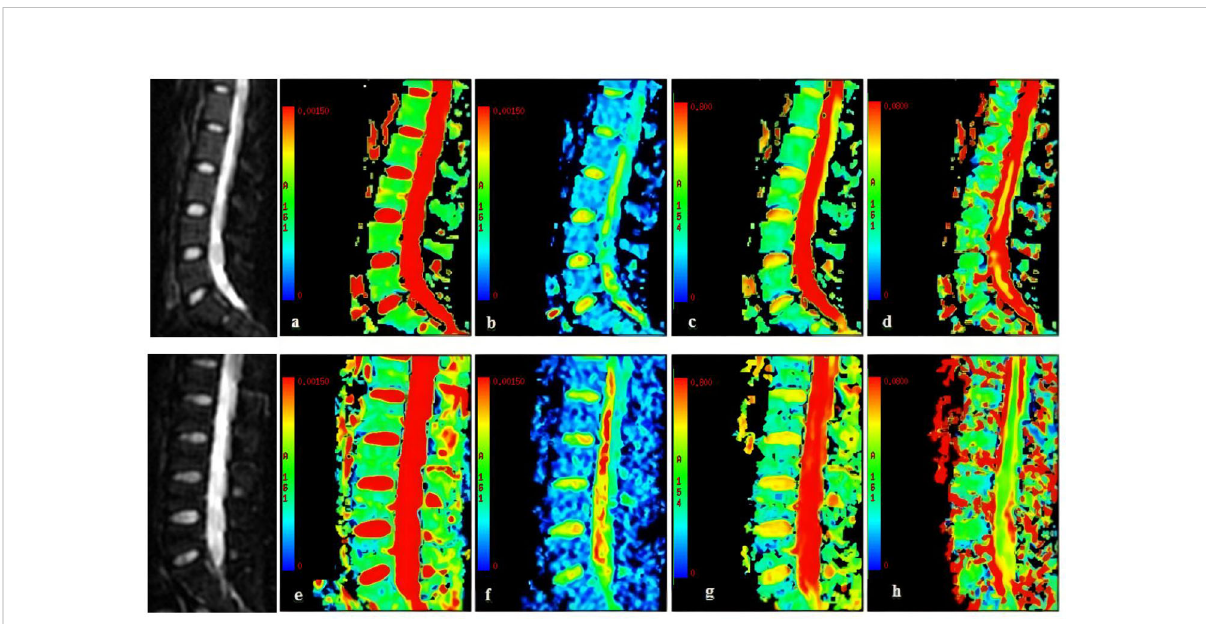
FIGURE 2 A 24-year-old woman (A – D) . (A) ADC map, ADC = 0.653 × 10 − 3 mm 2 /s; (B) D map, D = 0.308 × 10 − 3 mm 2 /s; (C) f map, f = 0.327; (D) D * map, D * = 46.0 × 10 − 3 mm 2 /s. A 25-year-old healthy man (E – H) . (E) ADC map, ADC = 0.588 × 10 − 3 mm 2 /s; (F) D map, D = 0.236 × 10 − 3 mm 2 /s; (G) f map, f = 0.294; (D) D * map, D * = 85.3 × 10 − 3 mm 2 /s. The two gray images on the left are images with b =